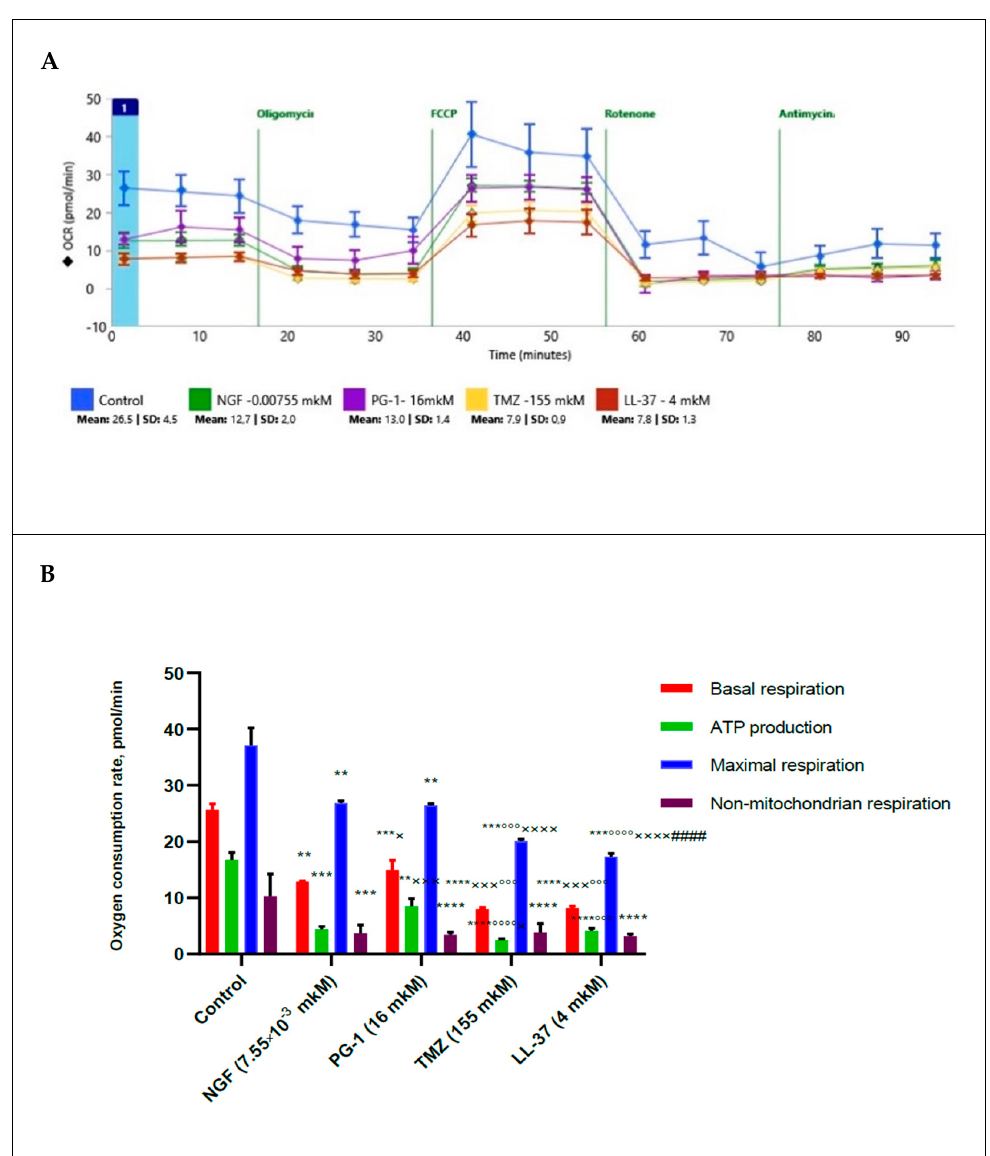
Figure 2. Oxygen consumption rate in human glioma U251 cells under the effect of NGF (7.55 × 10 − 3 μМ ), LL-37 (4 μМ ), PG-1 (16 μМ ), and TMZ (155 μМ ) over time ( A ); in comparison to control with reagents ( B ): **—significance ( p < 0.01), *** ( p < 0.001), **** ( p < 0.0001) from control; ×—significance ( p ≤ 0.05), ××× ( p < 0.001), ×××× ( p < 0.0001) from NGF; °°°—significance ( p < 0.001), °°°° ( p < 0.0001) from PG-1; ####—significance ( p < 0.0001) from TMZ.